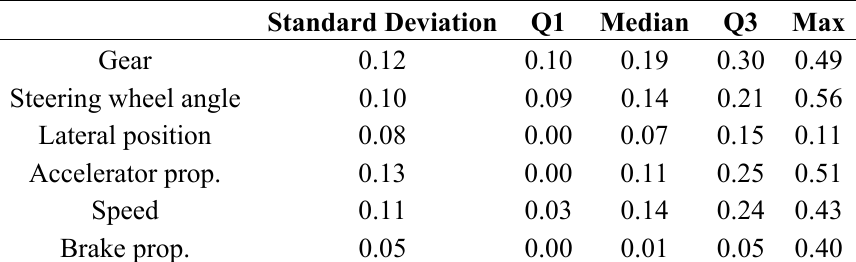
Table 8. Relevant characteristics for Expert 1.